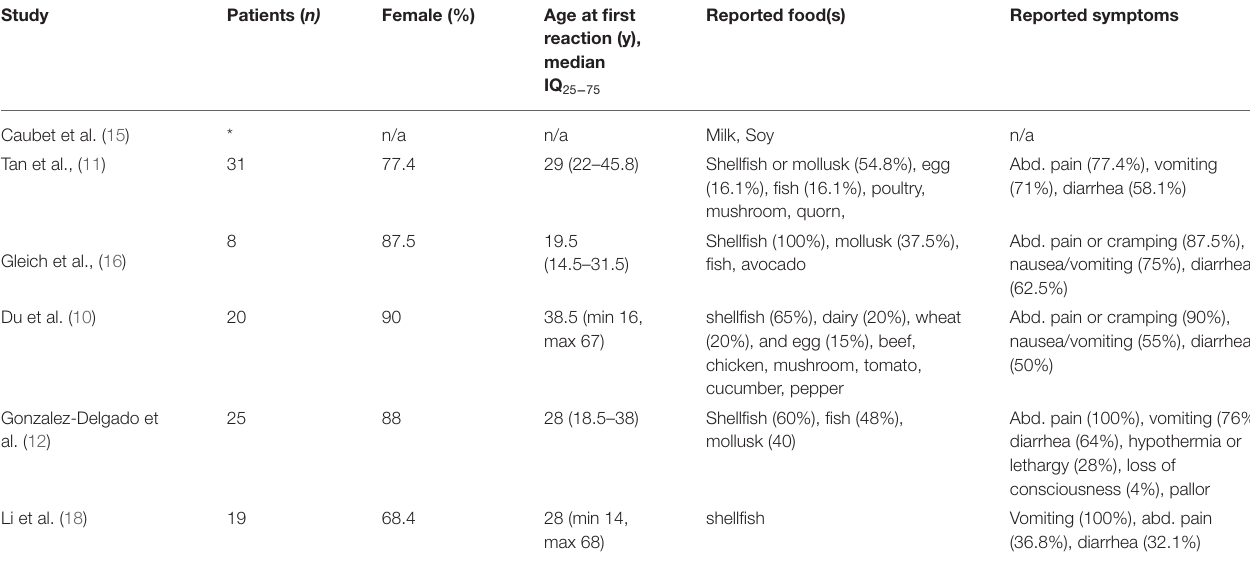
TABLE 1 | Summary of data from case series with adult FPIES patients.